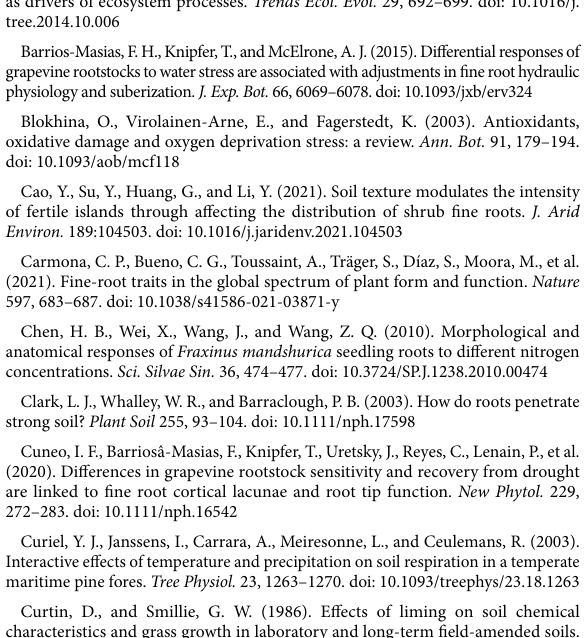
SUPPLEMENTARY FIGURE S1 One of treated fine roots of 1–5-ordee fine roots. SUPPLEMENTARY FIGURE S2 Anatomical structure of 1–5-order fine roots of Cupressus funebris from the 4 test sites. Magnification of anatomical structure: the images of 1- to 3-ordee fine roots were taken at ×10, and those of 4- and 5-order fine roots were taken at